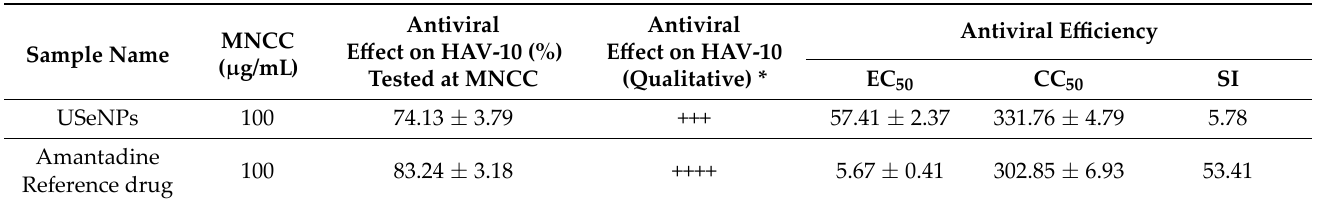
Table 1. The antiviral effects of the USeNPS against hepatitis A virus (HAV‑10) when tested at max‑ imum noncytotoxic conc (MNCC).